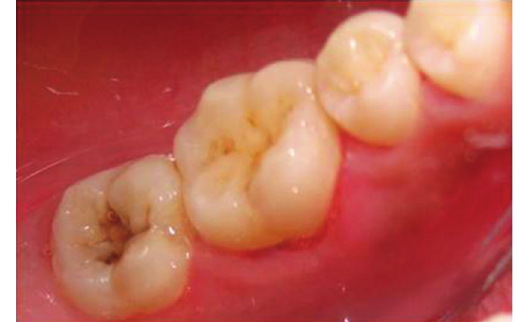
Figure 23: Lingual view of 36, seven days after reattachment with favourable periodontal response.